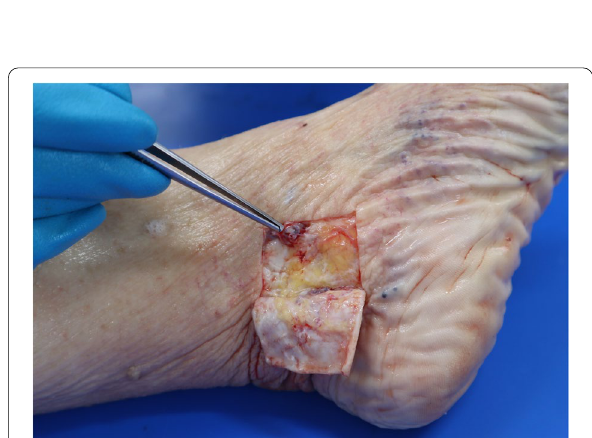
Fig. 5 Left medial malleolus with exposed subcutaneous tissue and the perforated varicose